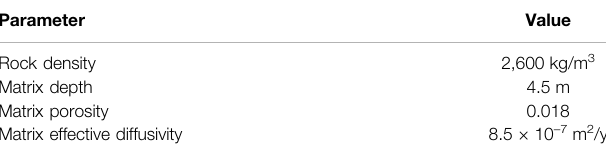
TABLE 1 | Parameters of the rock matrix used in the Conservative case and the Decay Chain case